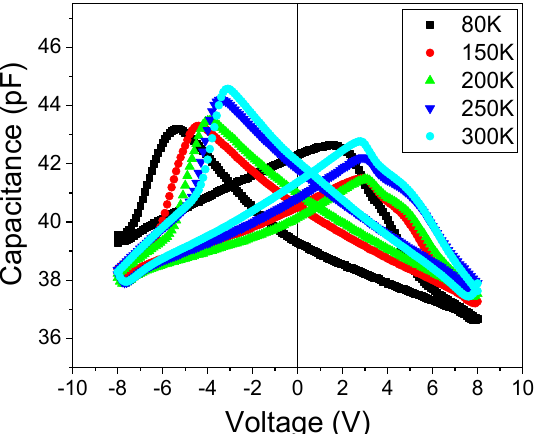
Figure 5. The capacitance-voltage characteristics were recorded at different temperatures.